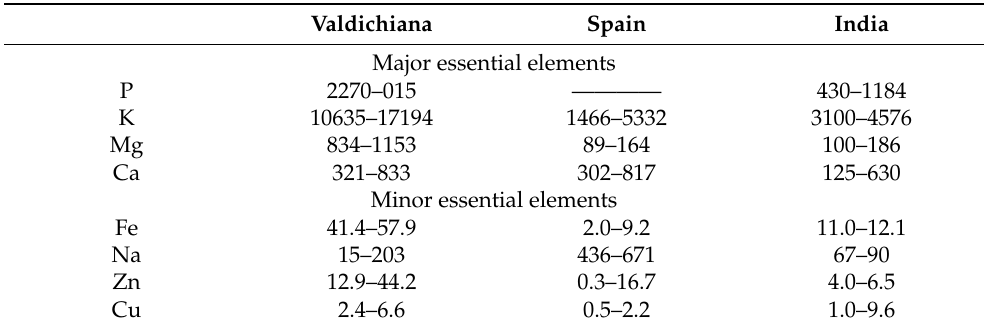
Table 2. Range of major and minor element concentrations (mg/kg dw) in elephant garlic cultivated in Valdichiana (present study), Spain [31], and India [32,33].